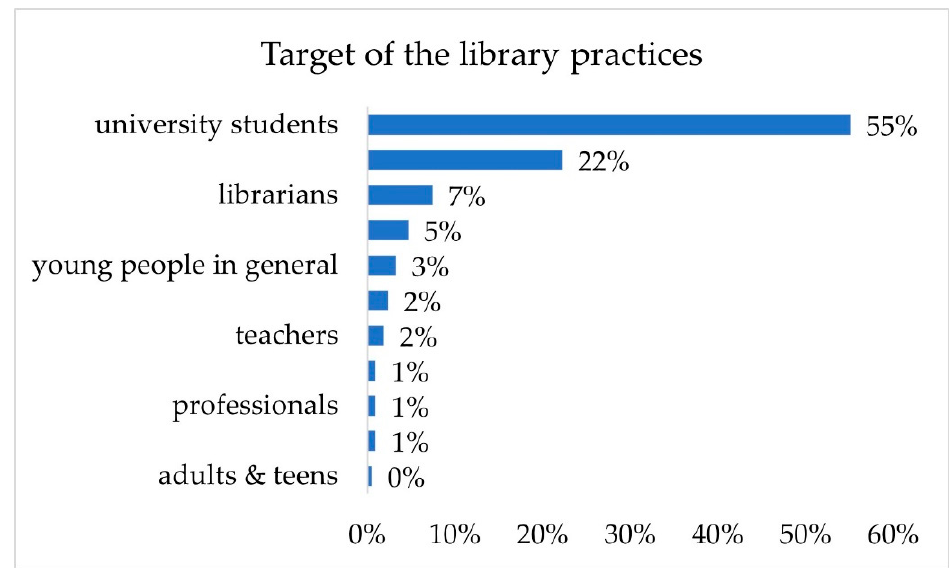
Figure 3. Type of library. Source: prepared by the authors.